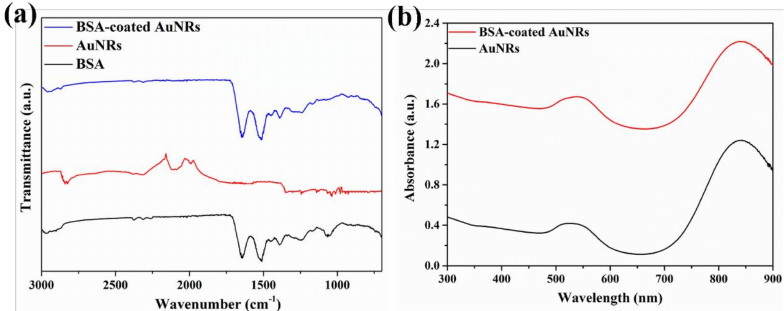
Figure 2. Fourier transform infrared spectra of bovine serum albumin (BSA), AuNRs and BSA-coated AuNRs ( a ) and VIS-NIR spectra of AuNRs and BSA-coated AuNRs ( b